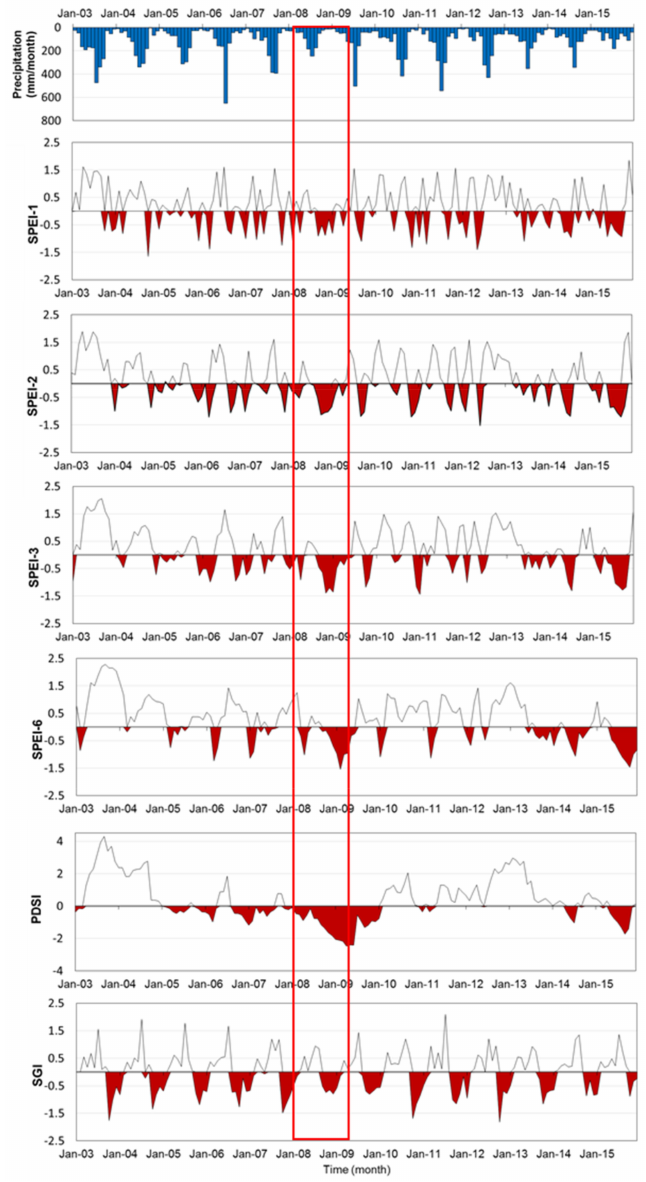
Figure 9. Time series of Standardized Precipitation − Evapotranspiration Index (SPEI)-1, -2, -3, -6, Palmer Drought Severity Index (PDSI), Standardized Groundwater Level Index (SGI), and monthly